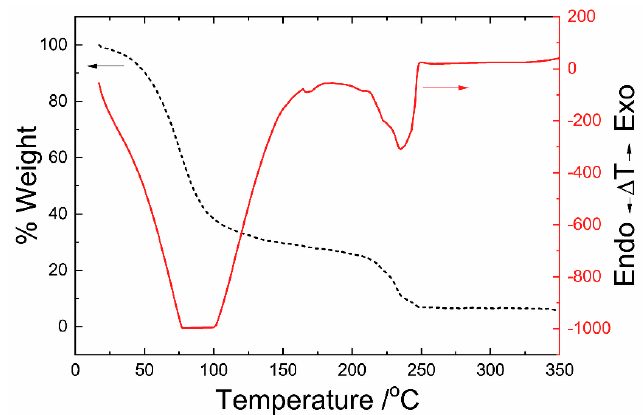
Figure 2. Thermogravimetric analysis (TGA) and differential thermal analysis (DTA) of the Ni metal organic decomposition (MOD) ink.